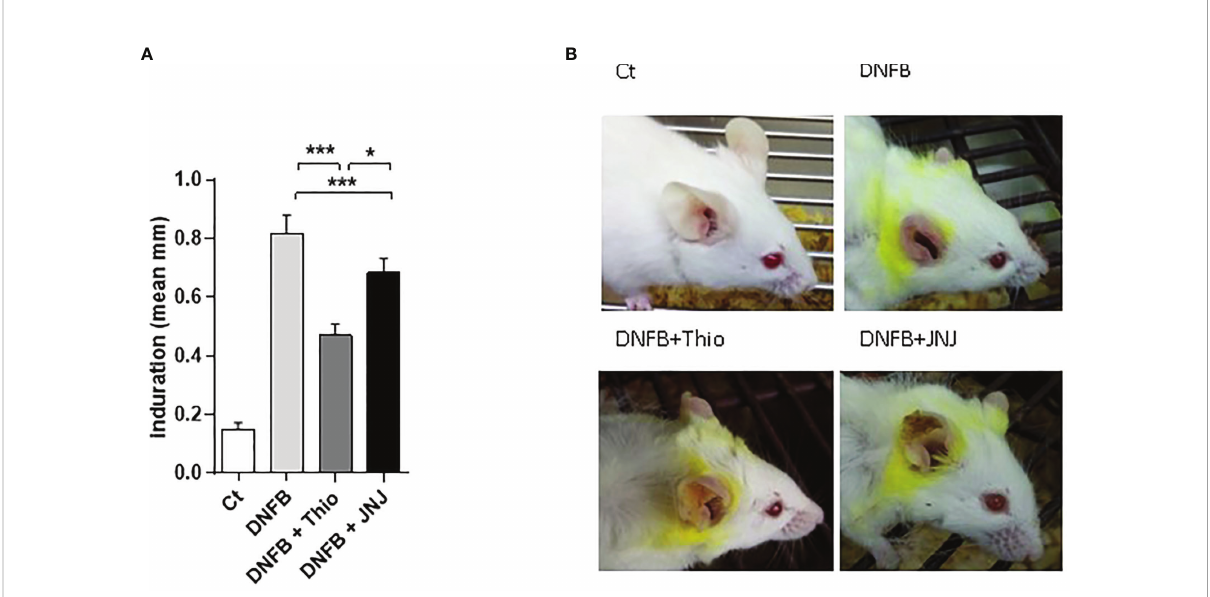
FIGURE 1 (A) Blockade of H 3 R and H 4 R decreases hapten-induced local in fl ammation in the ear (determined as ear thickness, measured with a caliper). The bars represent mean ± SEM values from nine mice. * p < 0.05; *** p < 0.001. ANOVA with Tukey ’ s post-test ( n = 9). (B) A representative image of the macroscopic appearance of the ear tissue at day 7 post challenge, for each